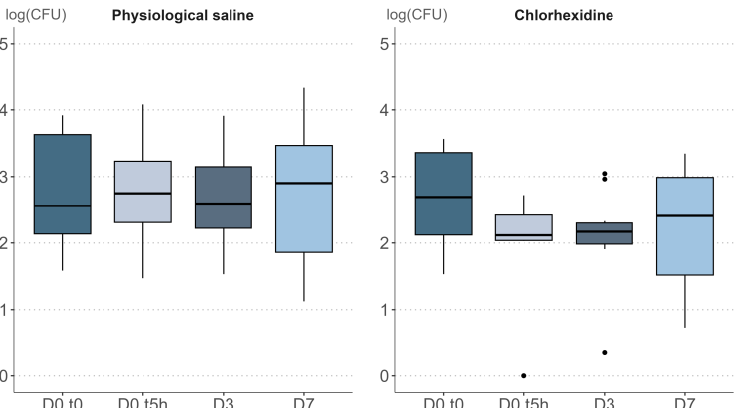
Figure 3. Study 5. Boxplot visualization of the impact of repeated physiological saline or chlorhexi- dine repeated applications on bacterial density, expressed in CFU/cm² on a log-scale. In the boxplot, the dots represent the outliers. The outiliers are defined as the values below Q1 − 1.5 IQR and the values above Q3 + 1.5 * IQR; Q1 and Q3 are the first and the third quartile, respectively, IQR is the interquartile range (Q3–Q1).